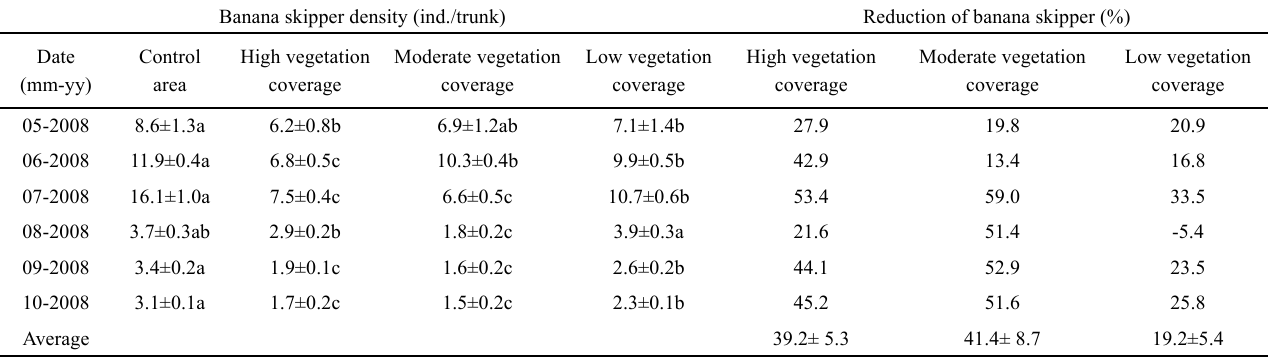
Table 2. Effects of S. invicta invasion on population of banana skipper E. torus . Banana skipper density (ind./trunk)